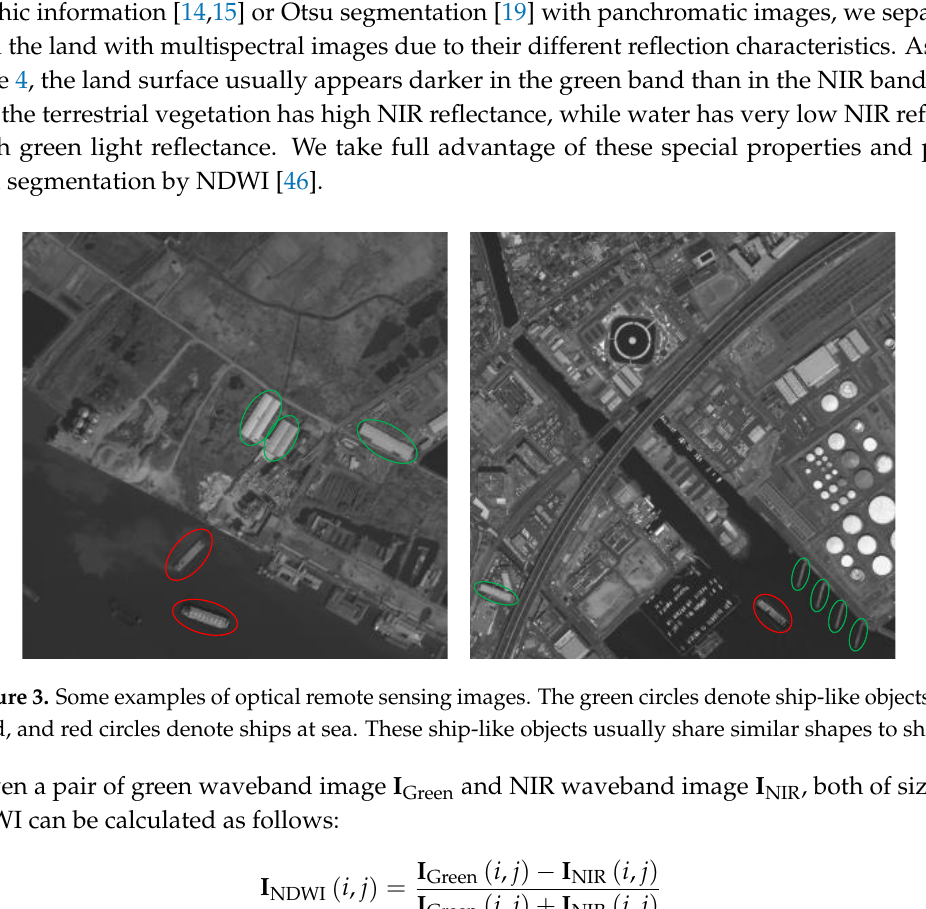
land, and red circles denote ships at sea. These ship-like objects usually share similar shapes to